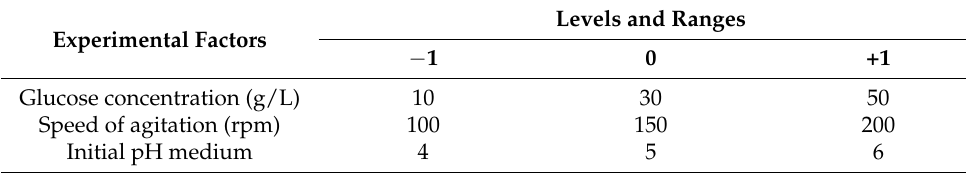
Table 1. The values of the levels and ranges of the experimental factors. Experimental Factors